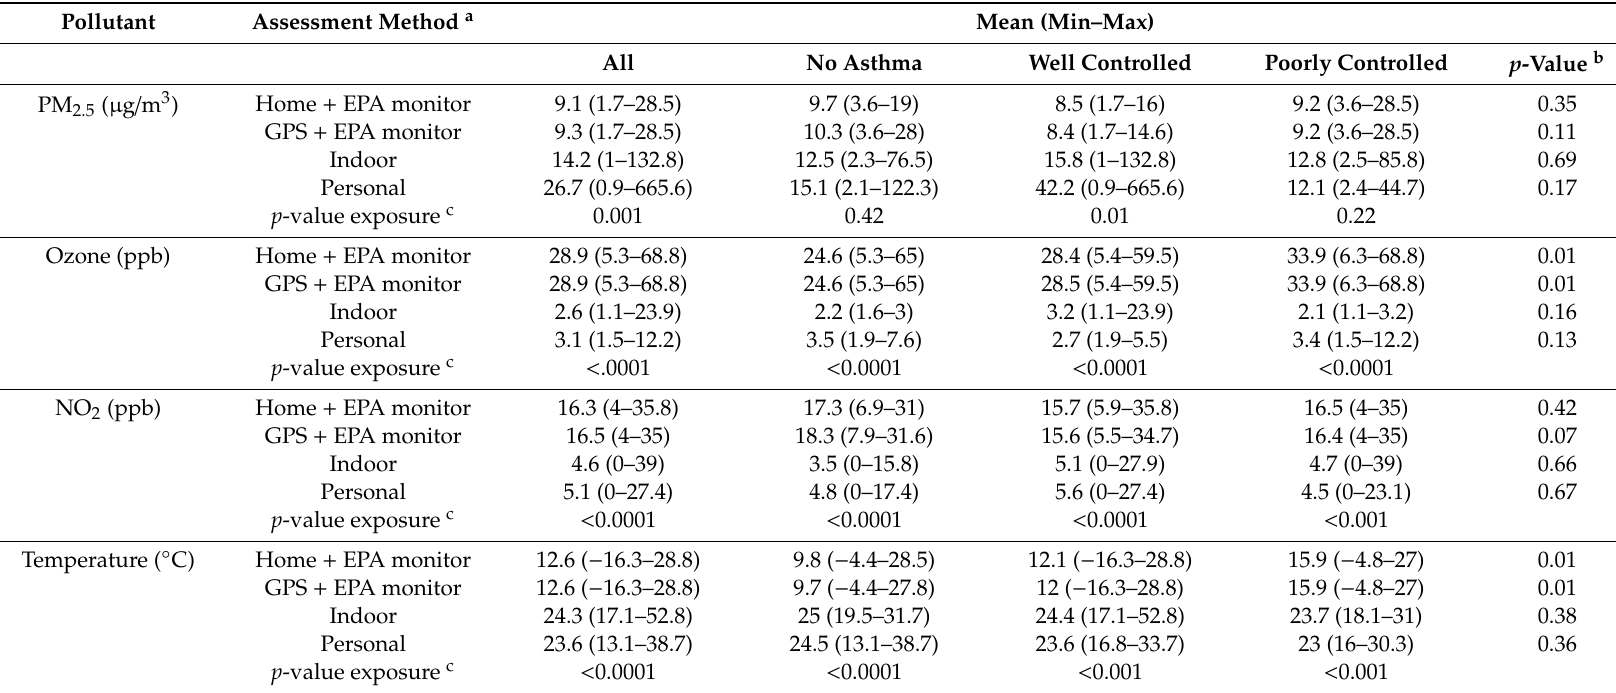
Table 2. Distribution of air pollution exposure by asthma